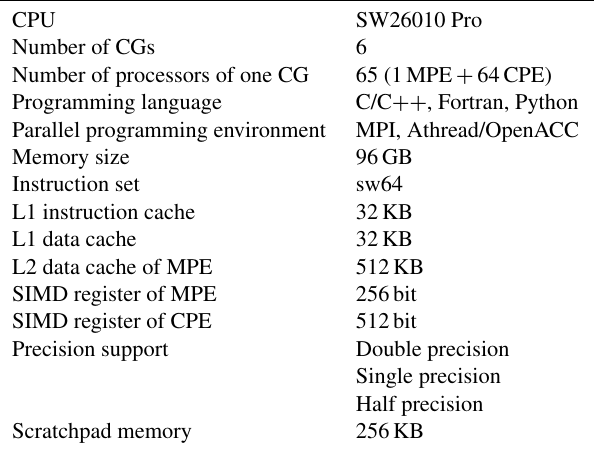
Table 2. Basic information about SW26010 Pro. Note: CG refers to core